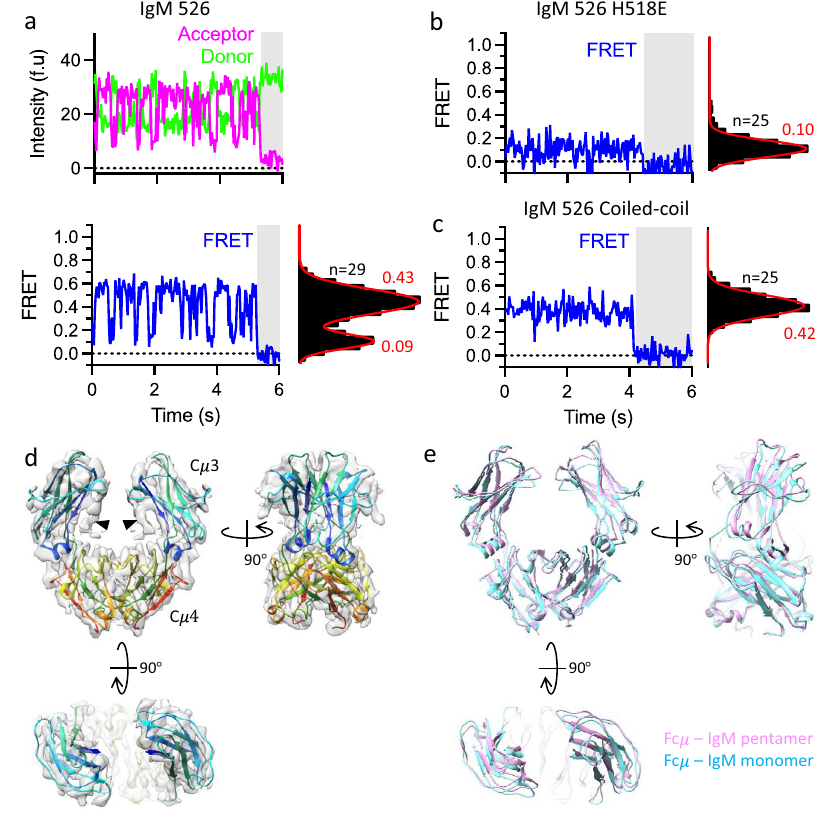
Fig.5|DynamicsoftheIgMmonomerbasedonsmFRETandcryo-EMstructure comparisons.a FRETdonor(green)andacceptor(magenta) fl uorescenceintensity traces and the calculated FRET ef fi ciency (blue) from a single molecule of a monomeric IgM-Fc construct labelled with the fl uorophores at position 526 in the EF helix of C μ 4. The shaded area indicates when the acceptor molecule is photo- bleached. The histogram along the right FRET axis shows the distribution of the single-moleculeFRETvaluesforthe n moleculesmeasured. b , c Examplesofsingle- moleculeFRETtracesandtherespectivedistributionofFRETvaluesformonomeric IgM-Fc constructs labelled at position 526 and containing either a mutation H518,